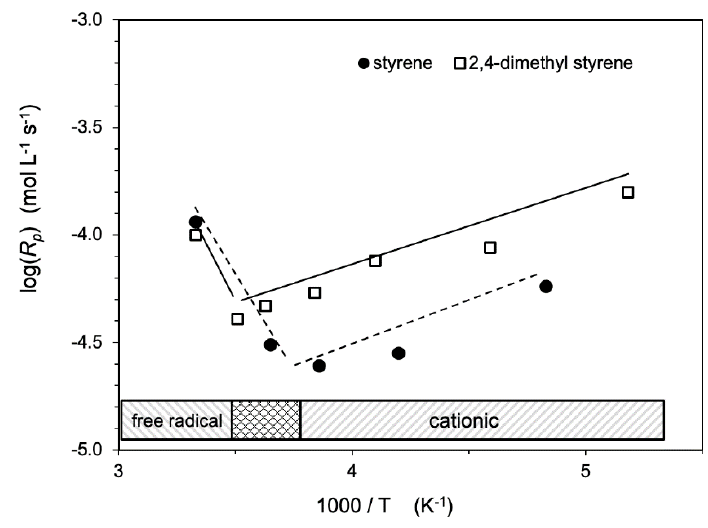
Figure 1. Temperature-dependence of the radiation induced polymerization of styrene and 2,4-dimethylstyrene revealing the temperature ranges favoring the occurrence of a cationic or of free radical mechanism (after [64]).